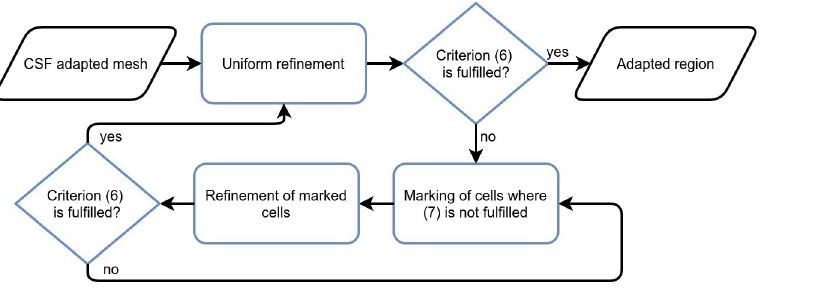
Fig 6. Flowchart of adaptive mesh